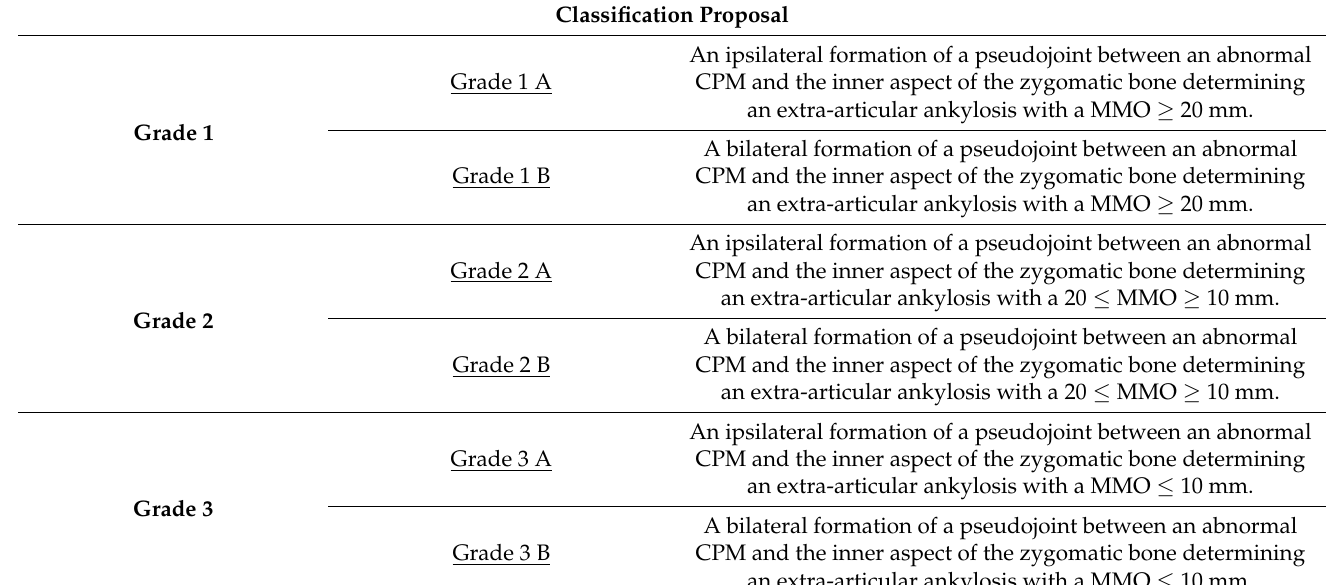
Table 2. Our proposal of JD’s